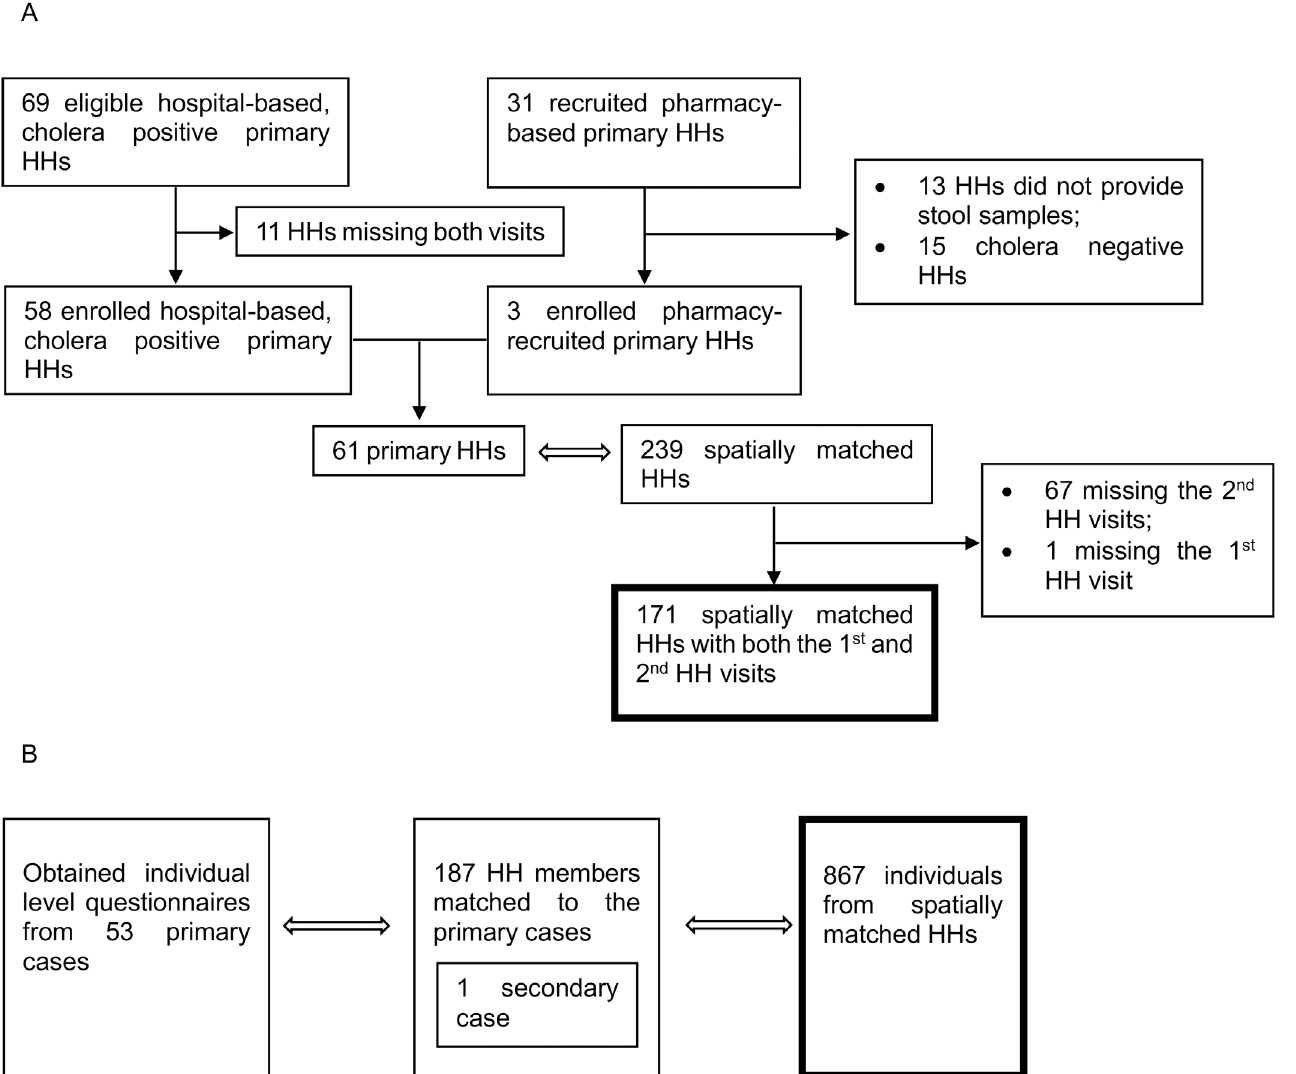
Fig 1. A flow chart outlining the enrolled households and individuals and those eligible for the study. A) For all household level exposures, only the data from the 171 spatially matched households participated in both household visits were considered. B) For analyses of individual level exposures, only the data from the 867 individuals in spatially matched households were